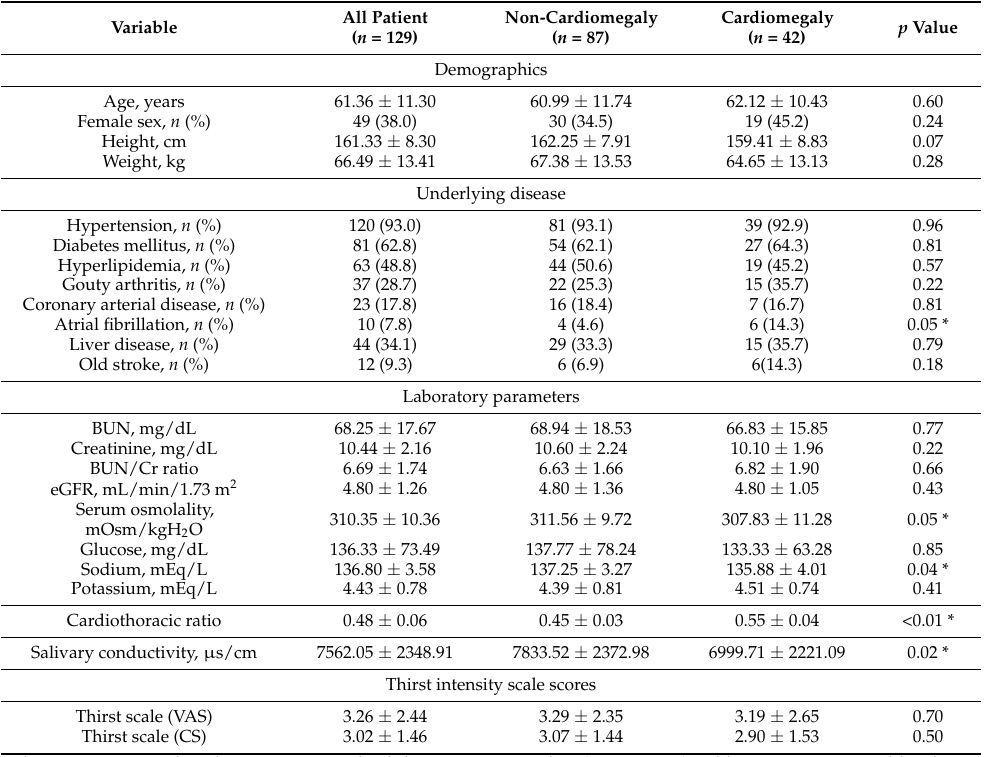
Table 1. Baseline characteristics of hemodialysis patients stratified by heart size ( n = 129).